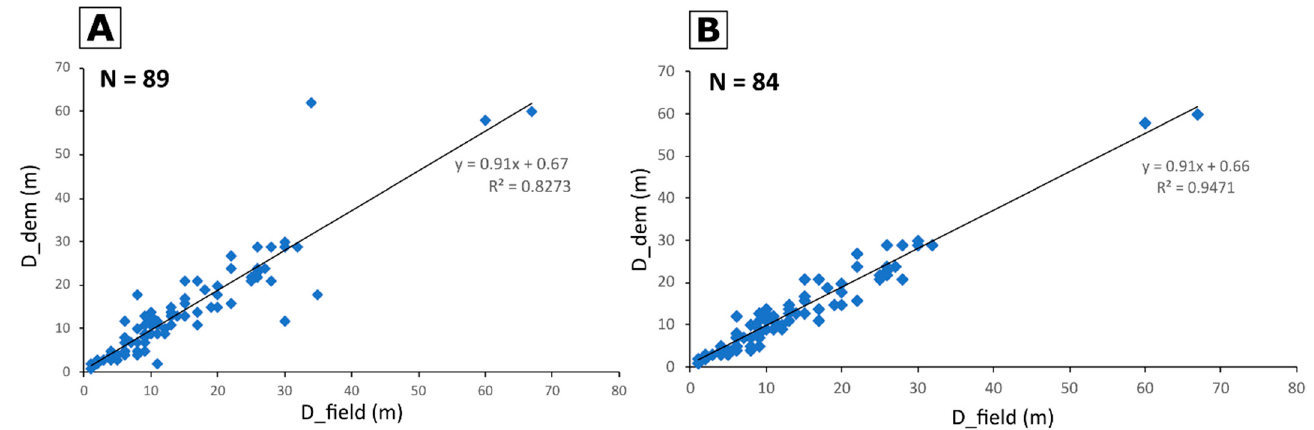
Figure 9. ( A ) Scatterplot of the depth (D) measures calculated in the field and in the DEM for the entire population (n = 89). ( B ) Scatterplot of the subset without outliers (n = 84). Lines represent the best-fit of the linear regression model.